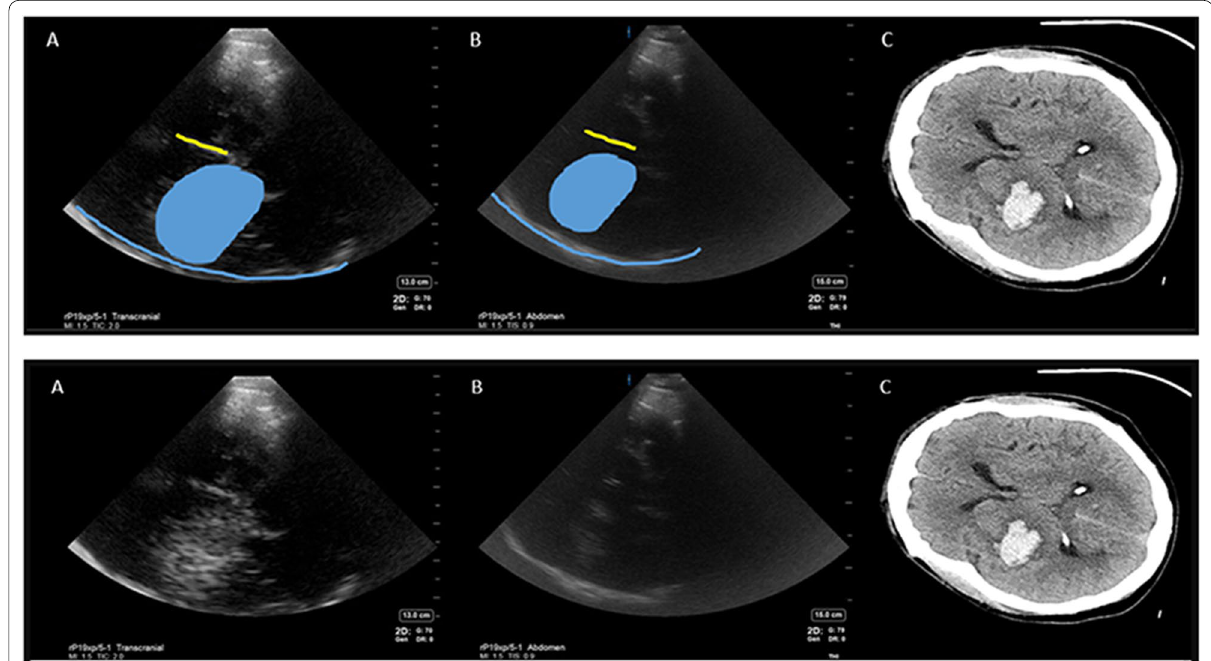
Fig. 3 Intracerebral hemorrhage visible as a hyperechoic signal best visualized contralateral to the insonated window. A —Transcranial preset, B —abdominal preset, C —COMPUTED tomography brain (CT) scan. Blue line—opposite skull, yellow line—falx cerebri, blue shape outlines the hyperechoic signal corresponding to hemorrhage on CT